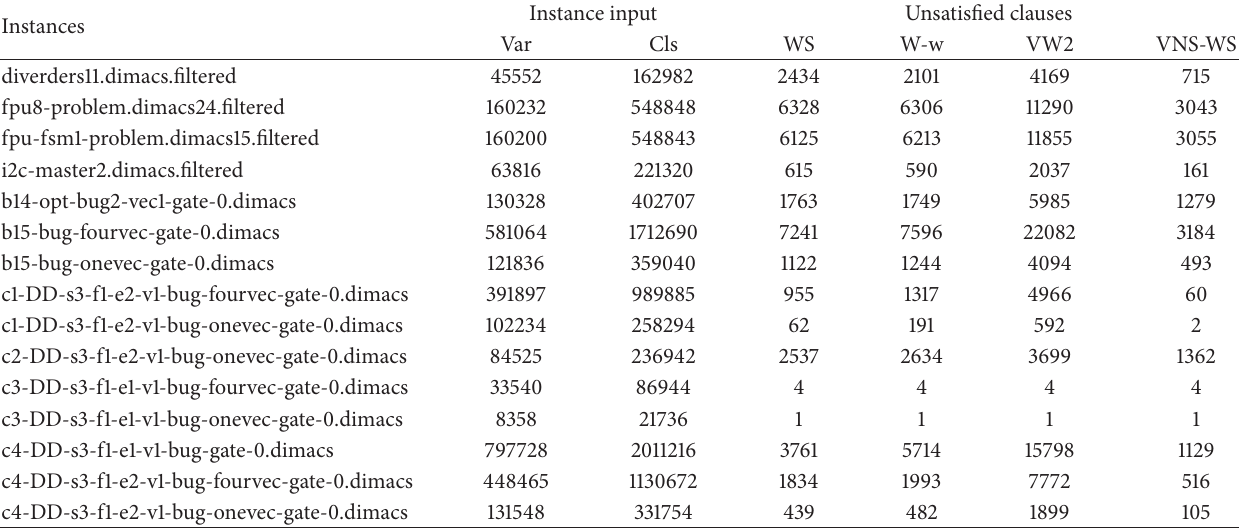
Table 1: SAT2013 industrial benchmarks: comparison among VNS-WS, WS, W-w, and VW2.